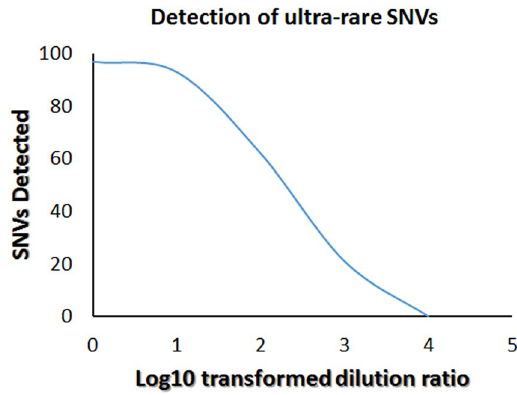
Figure 6. Detection of ultra-rare SNVs in libraries created from normal DNA spiked with sequentially diluted tumor DNA samples. Reduced amounts of variants were re-detected from sequentially diluted samples. No variant was re-detected from 1:10,000 diluted group. Coverage of re-sequencing is ~5,000